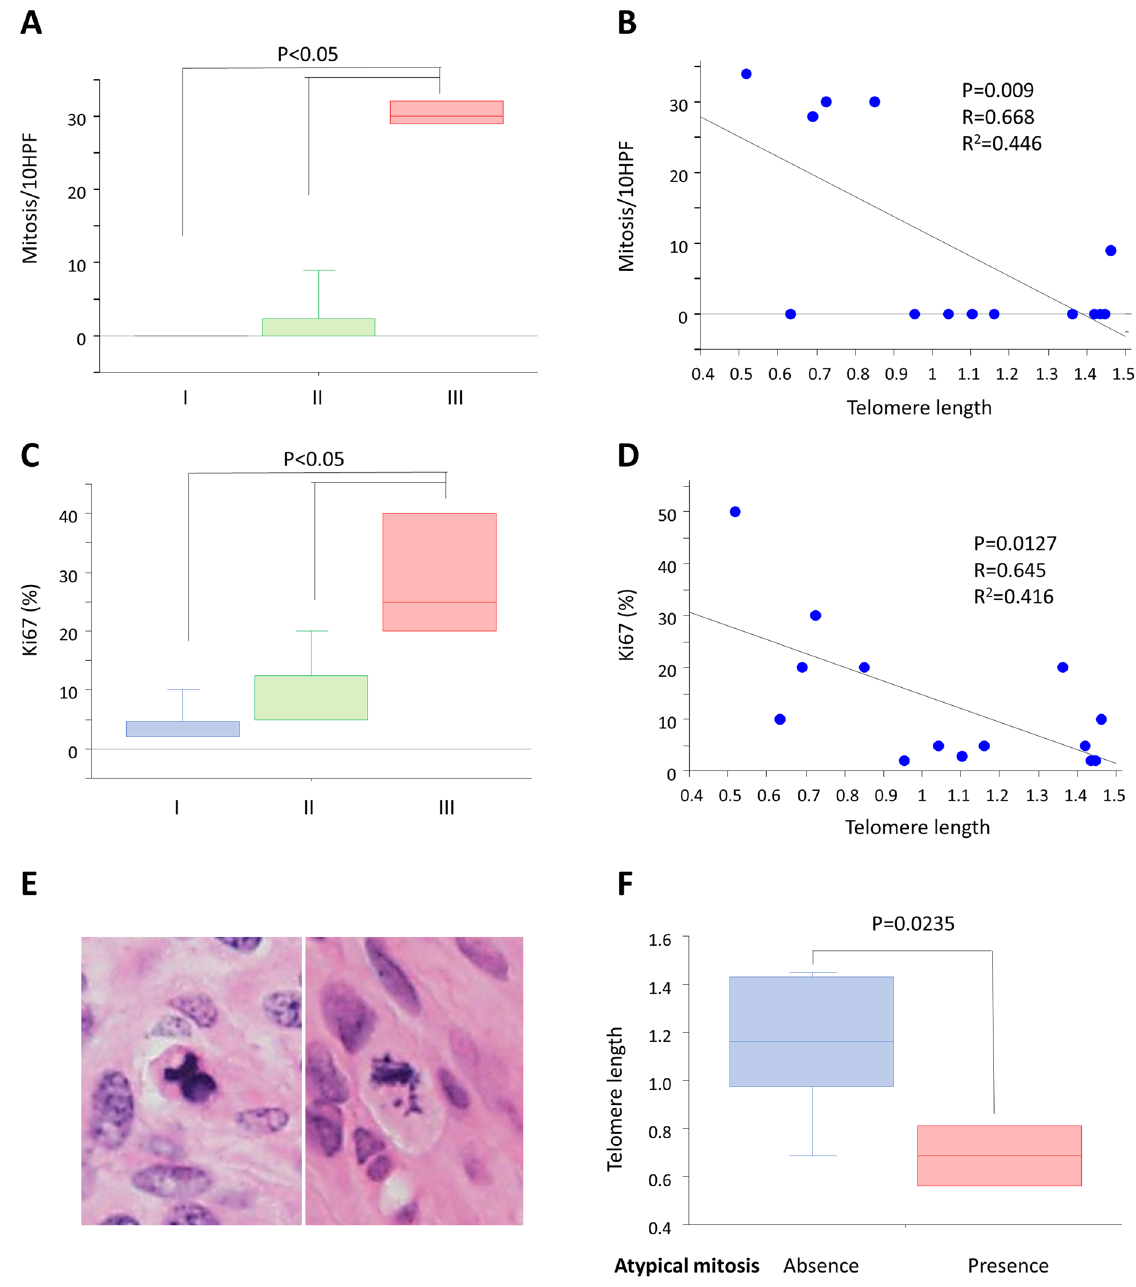
Figure 3. Telomere length was associated with cell proliferation and atypical mitosis. ( A ) WHO grade and the number of mitosis/10HPF. Tukey–Kramer test. ( B ) Telomere length and the number of mitosis/10HPF. ( C ) WHO grade and MIB1 index. Tukey–Kramer test. ( D ) Telomere length and MIB1 index. ( E ) Atypical mitosis in grade III meningiomas. ( F ) Telomere length and atypical mitosis. Student t-test. HPF high-power fields, WHO World Health